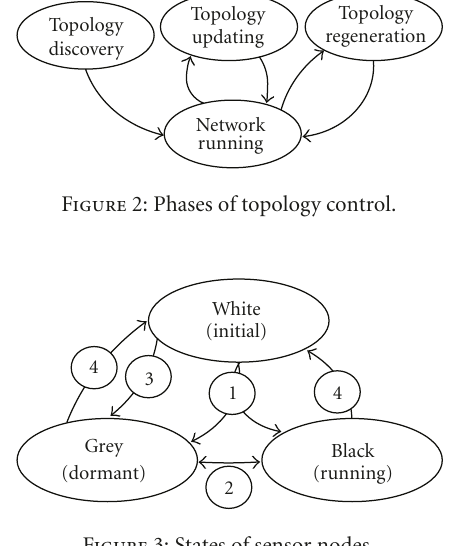
Algorithm 2 (Topology Self-Regeneration Algorithm). (1)